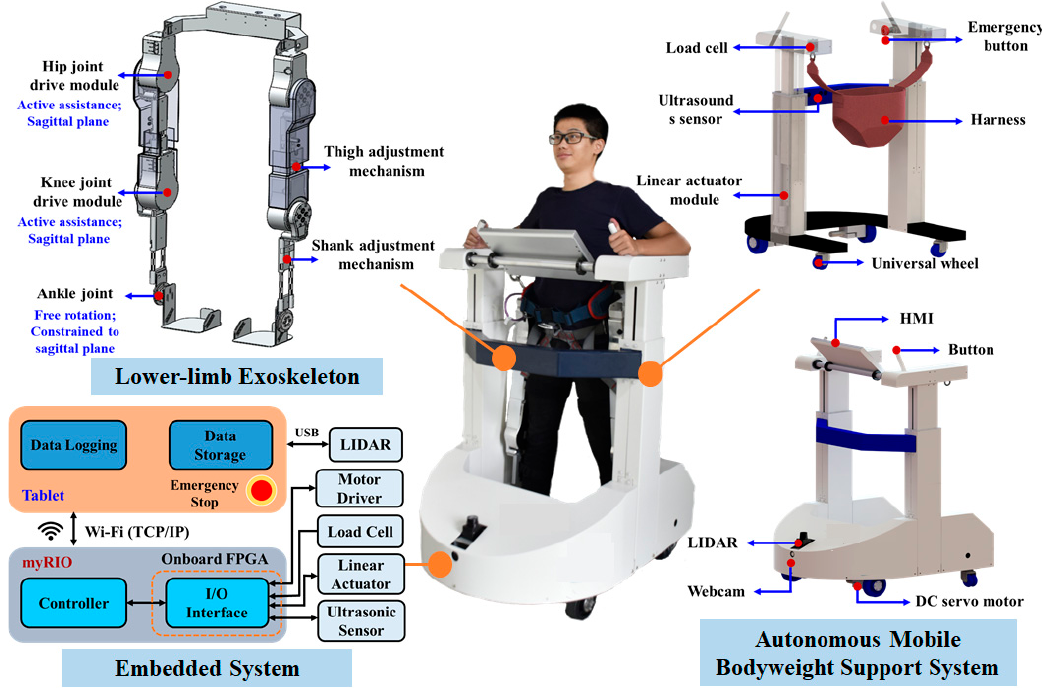
Figure 1. The overall design concept and prototype photos of the MRR.